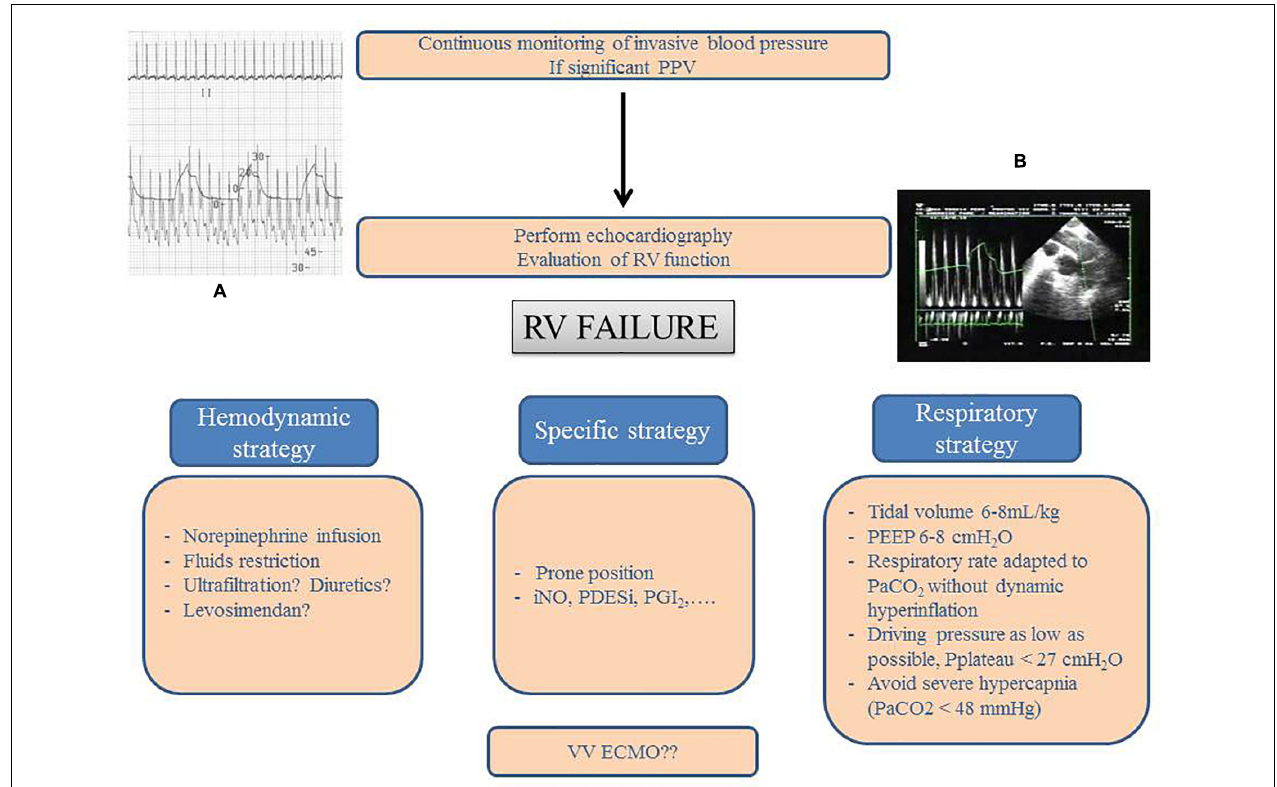
FIGURE 2 | Right ventricle protective strategy. Principles for detection and management of right ventricular (RV) failure in patients with ARDS. This should combine invasive blood pressure monitoring and echocardiography. In the case of significant pulse pressure variation (PPV, Panel A ), critical care echocardiography must be performed. It usually demonstrates cyclic decrease in RV outflow at each insufflation (Panel B on an upper esophageal view with pulsed wave Doppler into the main pulmonary artery) with either isolated RV dilatation or acute cor pulmonale. Management is based on three different strategies: hemodynamic, respiratory, and specific. VV ECMO can be considered in the case of persistent RV failure. PEEP, positive end-expiratory pressure; iNO, inhaled nitric oxide; PDESi, phosphodiesterase type 5 inhibitor; PGI 2 , prostaglandin I 2 ; VV ECMO, veno-venous extracorporeal membrane